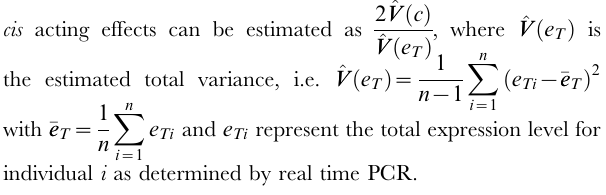
Figure S6 Effect of adjustment for covariates and outliers on total expression mapping. Scatter plots depict the estimates of effect size (A) and significance of association (B) for each of the 56 SNPs obtained using unadjusted total expression values (X-axis) versus values adjusted for covariates (age, sex, ethnicity) and with outliers removed (Y-axis). Pearson correlation coefficient (r) and the P-value for each association are shown in the top left of each plot.